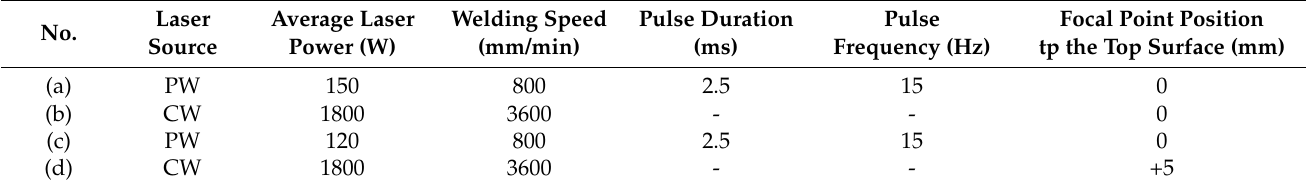
Table 3. The laser welding process